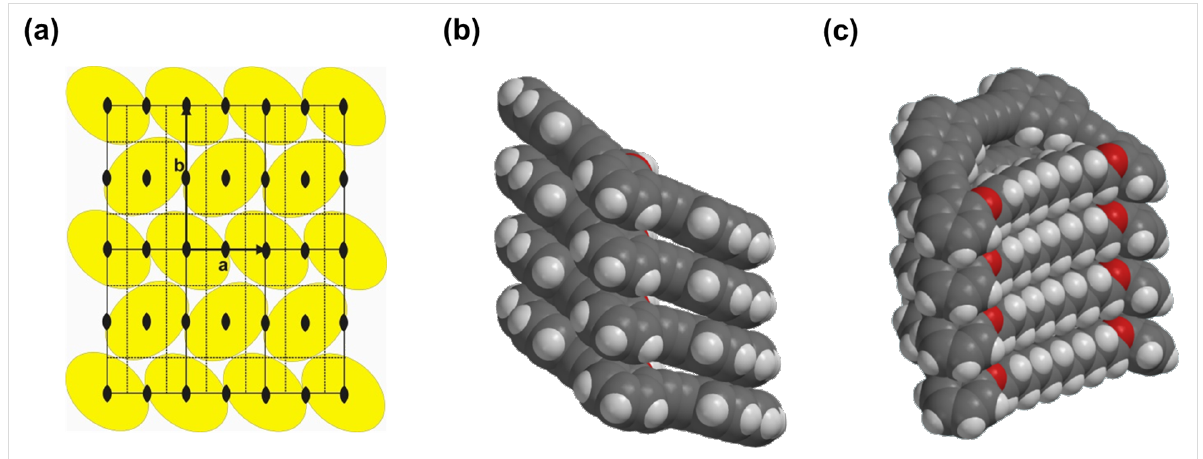
Figure 7: Model of the molecular packing in the columnar mesophase of 1a : (a) 2D packing scheme for the columns in the liquid crystalline phase (plane group p 2 gg , arbitrary cross section of the columns to fit the symmetry); MMFF calculation (Spartan ’08) of a tetramer of the macrocycles; (b) suggested stacking of the macrocycles within one column (side chains omitted for clarity); (c) visualization of the intraannular alkyl chain packing within the